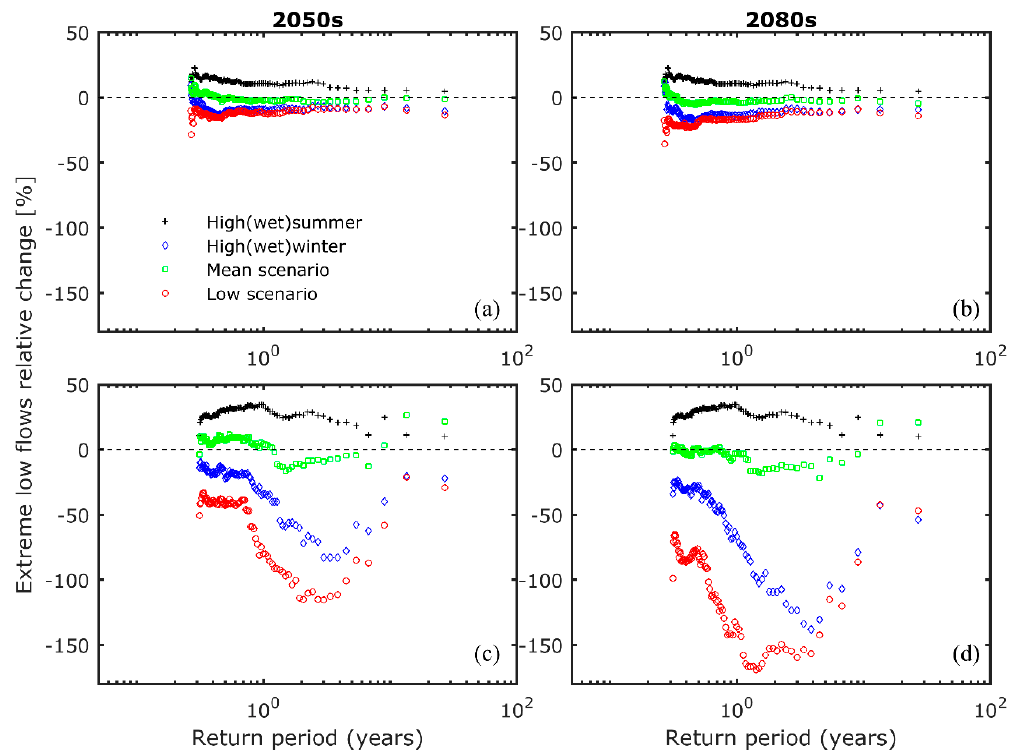
Figure 7. Relative changes of the daily extreme low flows of Zenne for the four applied scenarios compared to the baseline at Tubize ( a , b ) and Lot ( c , d ), indicating larger negative changes with high to medium return periods in the downstream part of the basin.